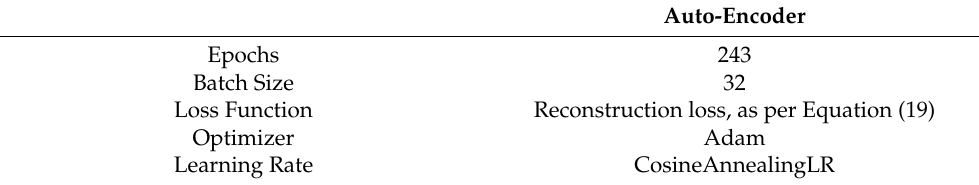
Table 2. The parameters set for the Auto-Encoder.